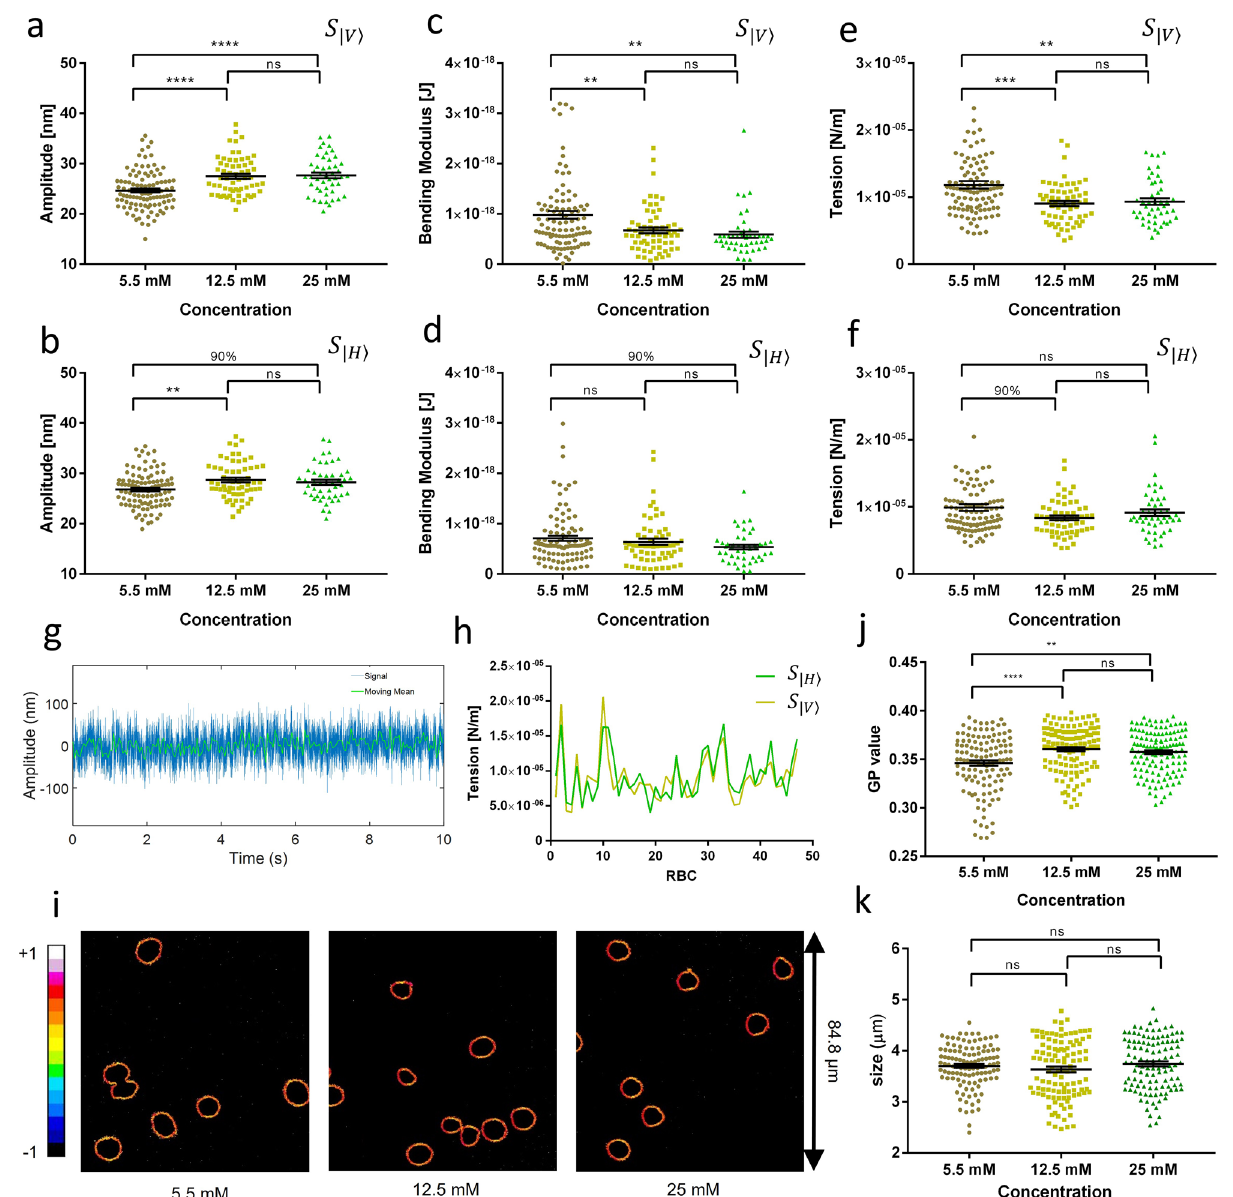
Figure 3. Mechanical parameters, fluidity, and size determinations for RBCs at different D-glucose concentrations. ( a , b ) Fluctuation amplitude distribution. ( c , d ) Bending modulus (κ distribution. ( e , f ) Tension module (σ). Data were obtained at spots S | V � ( a , c , e ) and S | H � ( b , d, , f ). Three concentrations of D-glucose were used: 5.5 mM (brown), 12.5 mM (yellow) and 25 mM (green). ( g ) A representative example of an amplitude signal versus time in seconds ( Matlab ver. 2018b ). The moving mean is highlighted in green, and the moving standard deviation is a dashed black curve. ( h ) Simultaneous tension values for both spots S | V � (mustard) and S | H � (green) obtained in individual RBCs. ( i ) Representative Laurdan GP images for the three D-glucose concentrations used ( ImageJ ver. 1.46o ). An arbitrary color scale is used for the GP values ranging between − 1 and + 1. ( j ) Fluidity (GP values) for individual RBC versus D-glucose concentration (N = 125 for each treatment). ( k ) Erythrocyte size for individual RBCs (N = 112 for each treatment) for the three D-glucose treatments. For the ANOVA test, the following parameters were used for P-value confidences. ‘**’ P = 0.001 up to 0.01, or 99%; ‘****’ is P < 0.0001, > 99.9%; and ns means ‘no significance’. The calculations of P-values, mean values and mechanical parameters were performed with these non-artifact data, which are RAW data. Symbols: from the ANOVA test ( GraphPad Prism ver. 7 ), we used P-value confidences. 90% corresponds to P-values between 0.05 and 0.1; ‘*’ is P = 0.01 up to 0.05 of confidence, or 95%; ‘**’ is P = 0.001 up to 0.01, or 99%; ‘***’ is P = 0.0001 up to 0.001 or 99.9%; ‘****’ is P < 0.0001, > 99.9%; and ns means ‘no